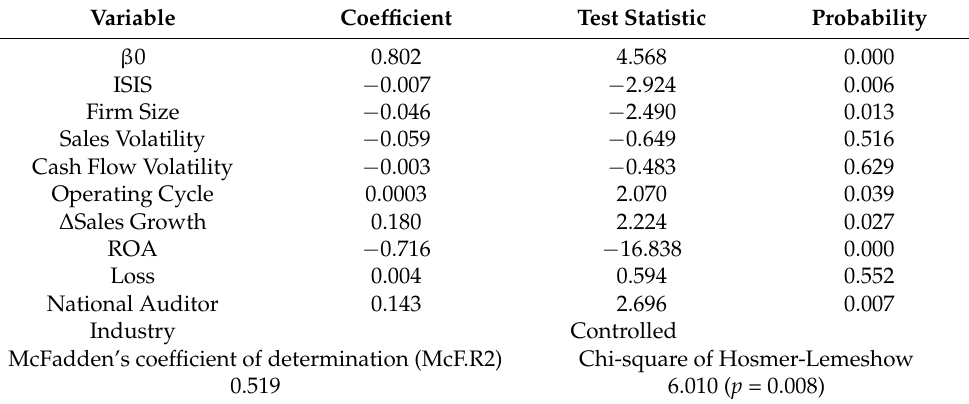
Table 3. The results of a statistical test of research